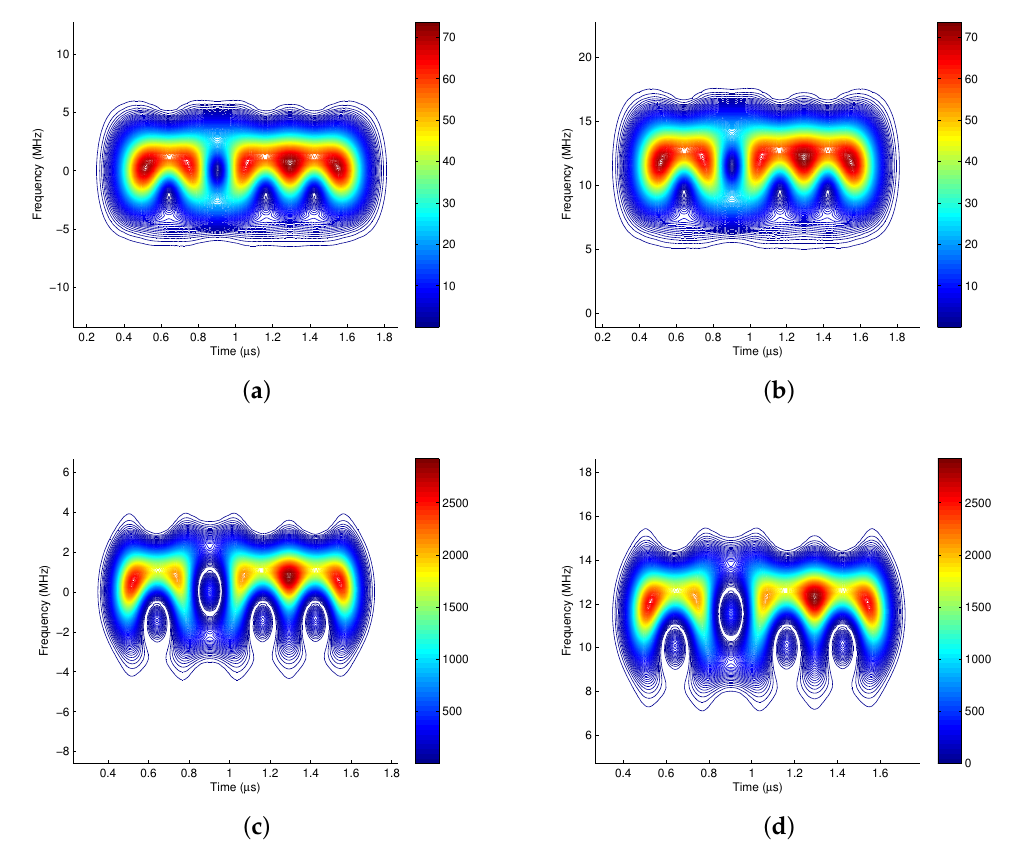
Figure 9. Realizing time-frequency equivalent analysis of baseband and RF by adding Hamming window and zero padding. ( a ) baseband complex signal, with hamming analysis window and zero padding, STFT, L h = 40; ( b ) RF signal, with hamming analysis window and zero padding, STFT, L h = 40; ( c ) baseband complex signal, with hamming analysis window and zero padding, CW, L h = 40; ( d ) RF signal, with hamming analysis window and zero padding, CW, L h =